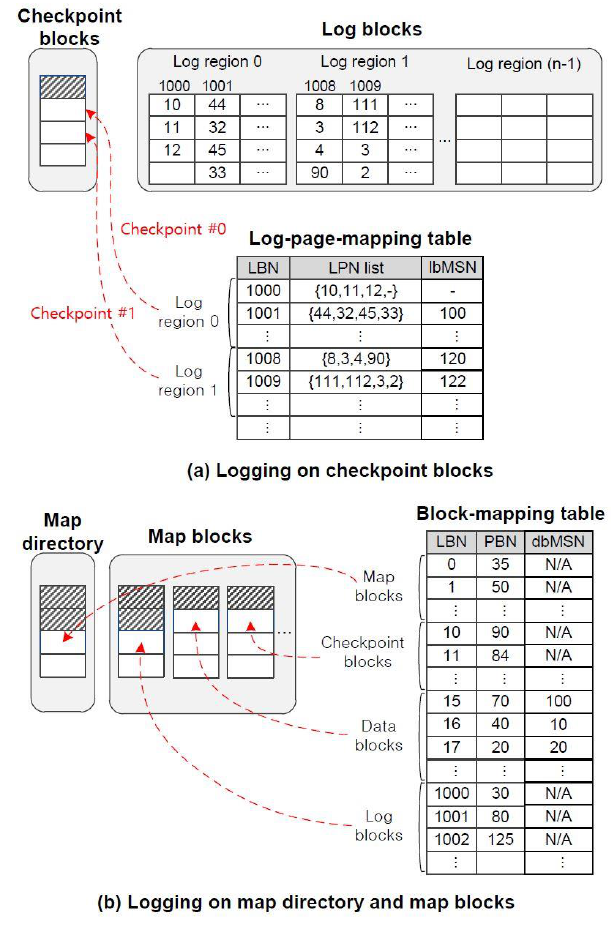
Figure 3. Logging operations in FAST.